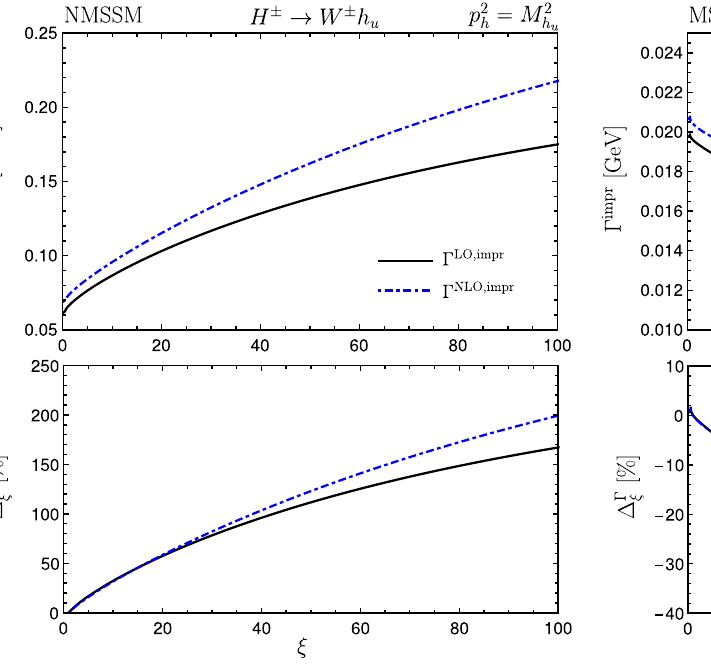
Fig. 10 Parameter point P1: gauge dependence of the LO and NLO decay widths in the NMSSM (left) and its MSSM limit (right). (cid:14) impr depicts widths calculated using the resummed Z matrix defined in